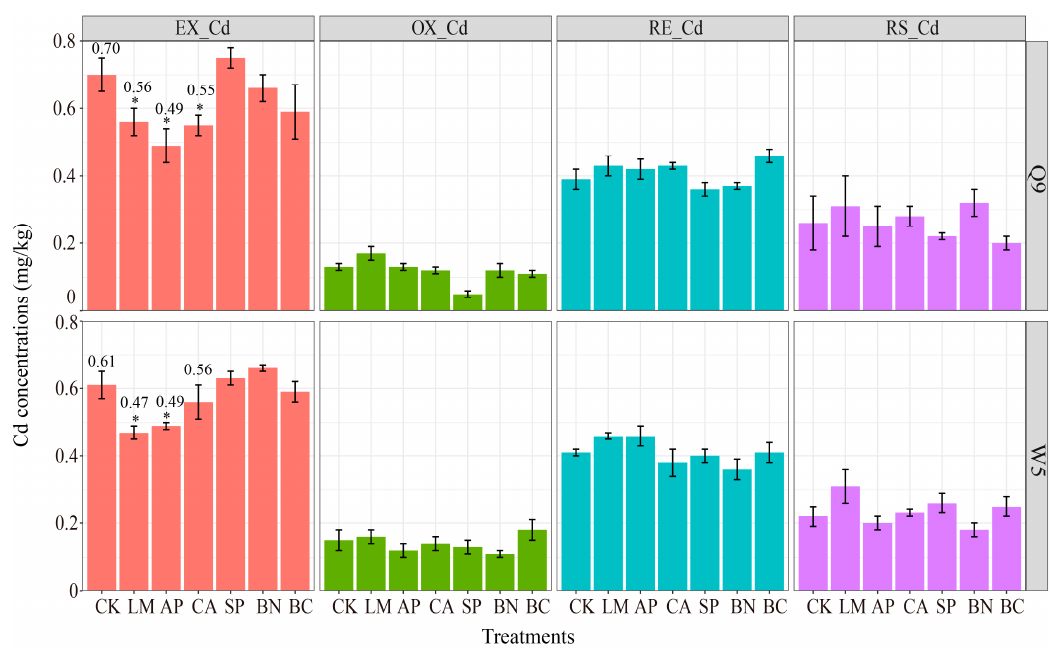
Figure 1. Effect of the morphology of Cd in Cd-contaminated soil after the application of different materials; Q9 and W5 represent the potato cultivar; EX-Cd, RE-Cd, OX-Cd, and RS-Cd represent exchangeable, reducible, oxidizable, and residual Cd, respectively; asterisks represent a significant difference from control (CK) ( p < 0.05, ANOVA; pairwise-Tukey’s HSD). CK, Control; LM, Lime; CA, Calcite; AP, Apatite; SP, Sepiolite; BN, Bentonite; BC, Biochar.